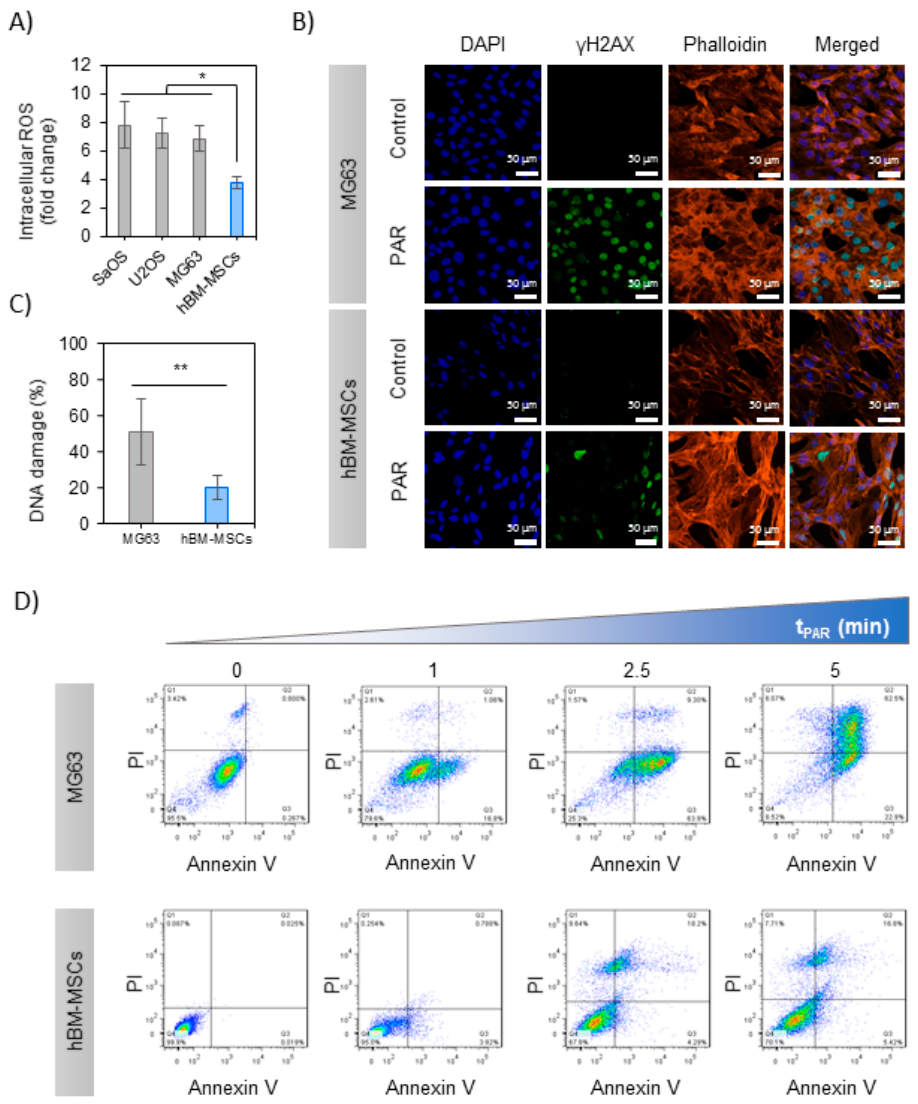
Figure 3. PAR-induced selective cell death in MG-63 cells rather than in hBM-MSCs. ( A ) Intracellular ROS measurement; OS cell lines and hBM-MSCs were incubated with dichlorofluorescin diacetate (DCFH-DA) and exposed during 2 h to PAR treated during 5 min by APPJ and after that fluorescence was measured. Values were relativized to negative control. ( B ) % of DNA damage quantification (positive γ H2AX area relativized to DAPI area; images: n = 5, mean of 70 nuclei per image). Asterisks represent statistically significance ( n = 3; * p -value < 0.05; ** p -value < 0.01; ANOVA and two-sided Student’s t -test). ( C ) Representative images of MG-63 and hBM-MSCs cells after 2 h of exposition to 5 min-treated PAR by APPJ. Cells were labelled with DAPI (nuclei, blue), phalloidin (F-actin, orange) and anti- γ H2AX (DNA damage reporter, green). Scale bar = 50 µ M. ( D ) MG-63 and hBM-MSCs cultures were exposed during 2 h to untreated PAR and treated during 1, 2.5 and 5 min with APPJ. After that, PAR was replaced by fresh medium. Cells were collected 24 h after PAR exposure and then they were stained with Annexin-V / PI and analyzed by flow cytometry. This assay was done in triplicate.